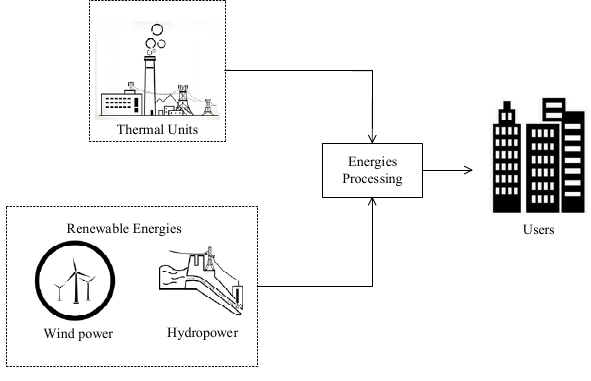
Figure 1. The hybrid power system.